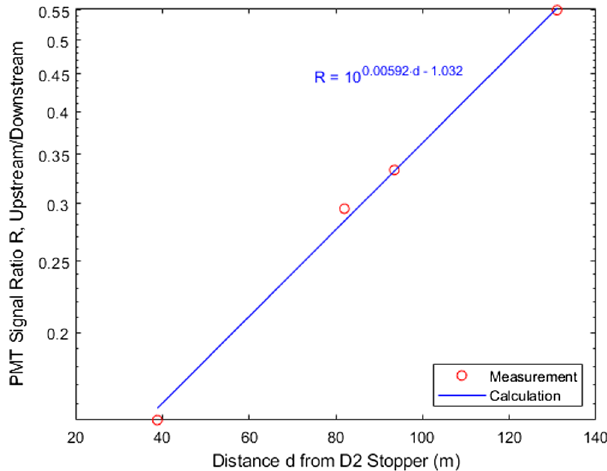
FIG. 14. PMT1/PMT2 ratio. The calculated slope comes only from the properties of the Cherenkov light, fiber, and PMT. The vertical offset, from a fit to the measurements, determined that the signal from the backward loss shower was 27% of the forward